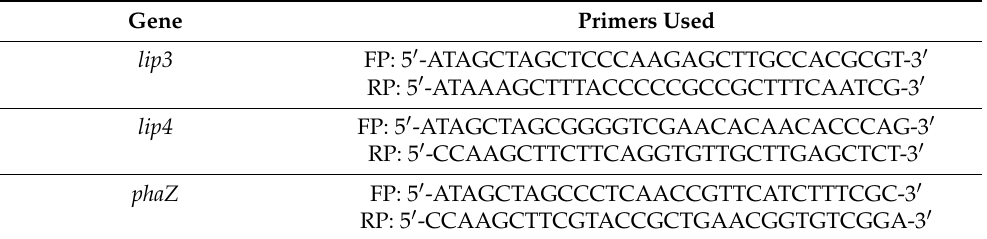
Table 9. Primers for the construction of recombinant lip3 , lip4 , and phaZ in the pET28a vector. Gene Primers